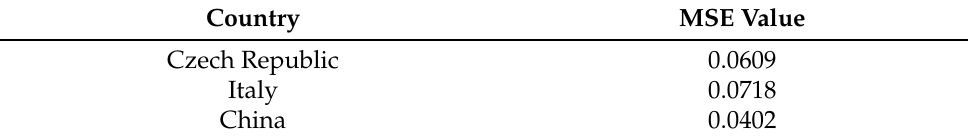
Table 6. The MSE values between actual EP and estimated EP for the Czech Republic, Italy, and China.